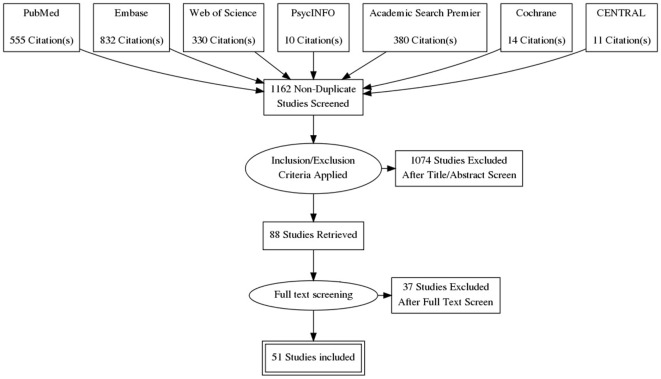
Prisma flow diagram.